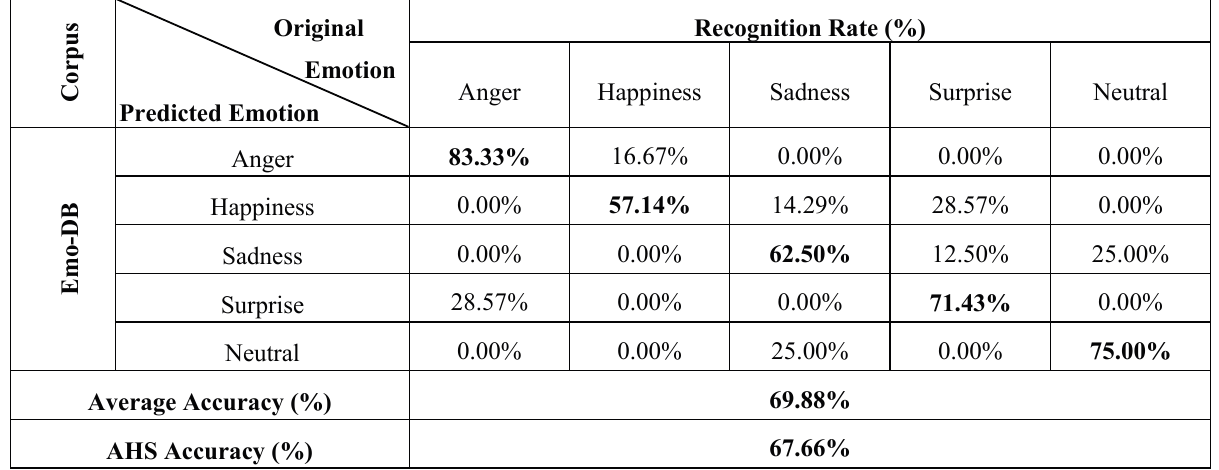
Table 10. Evaluation of ESS proposed by Ashish using MFCC feature with HMM classifier.